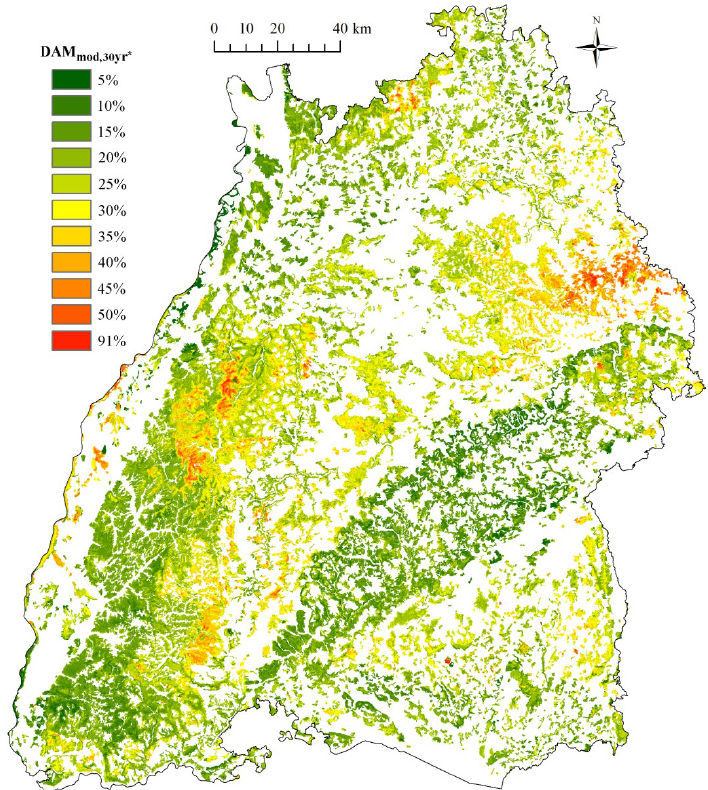
Figure 17. Map of modeled proportions of storm-damaged timber in the period 1979–2008 with Wiebke and Lothar gust speed fields being included in model building ( DAM mod,30yr* ). The legend values indicate highest class values.